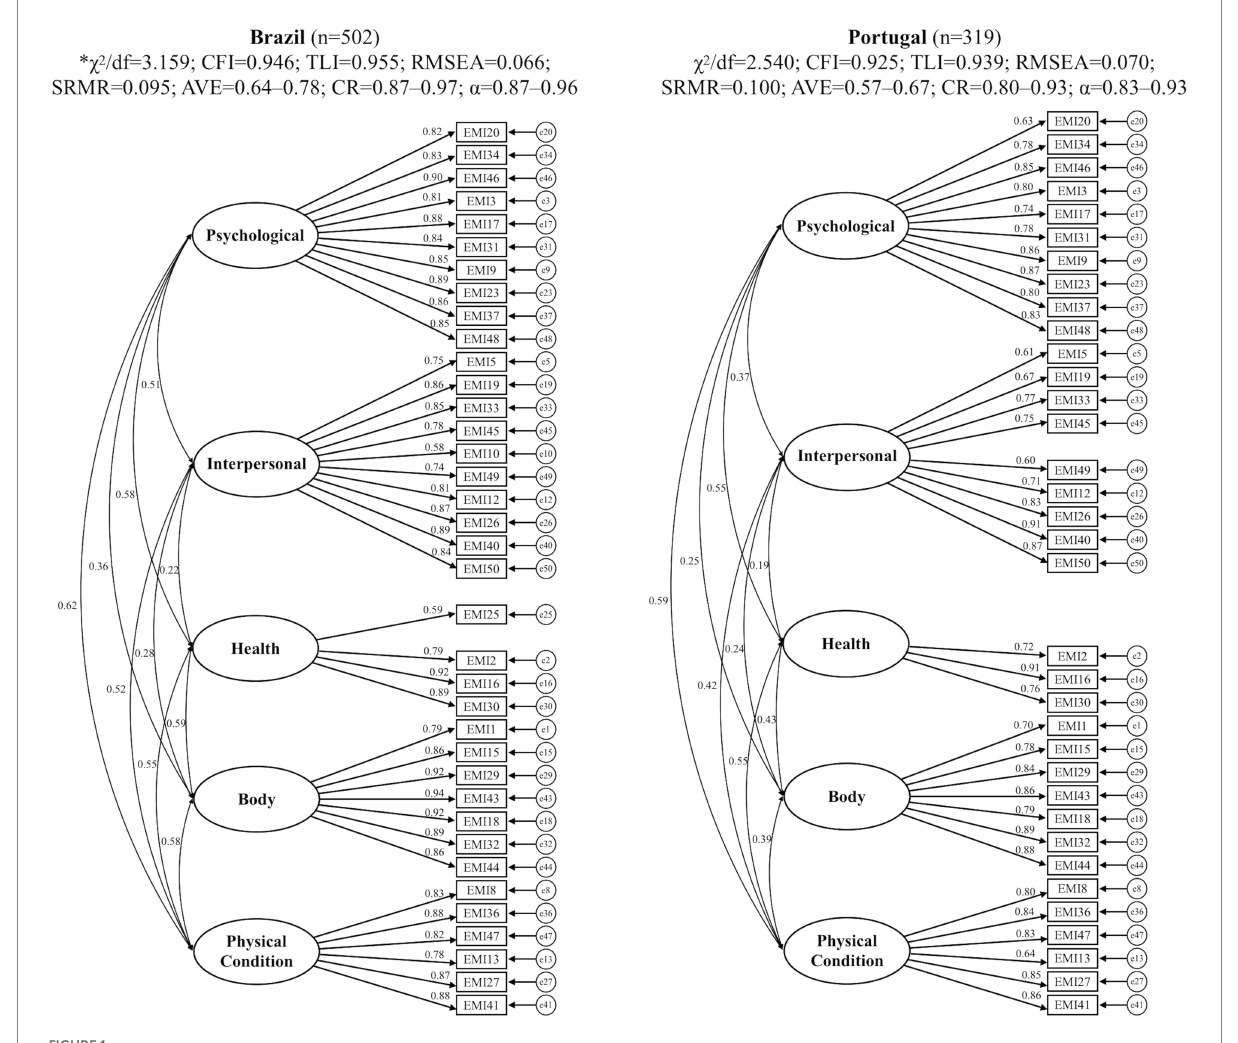
FIGURE 1 Factorial models fitted for the Brazilian and Portuguese